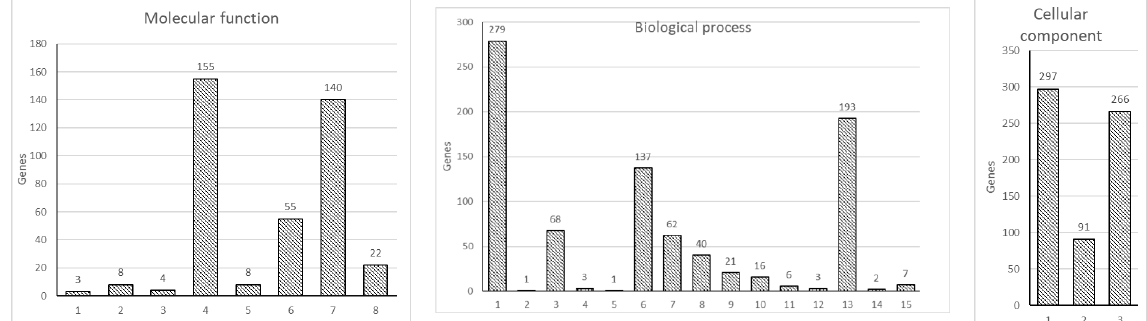
Figure 2. Gene ontology enrichment analysis of DEG. 753 DEG were analyzed for enrichment in three GO ontologies: biological process, cellular component, and molecular function. The number of genes enriched in individual GO terms is indicated on top of the individual bars. Molecular function: (1) translation regulator activity; (2) molecular transducer activity; (3) molecular adaptor activity; (4) binding; (5) structural molecule activity; (6) molecular function regulator; (7) catalytic activity; (8) transporter activity. Biological process: (1) cellular process; (2) reproductive process; (3) lo-